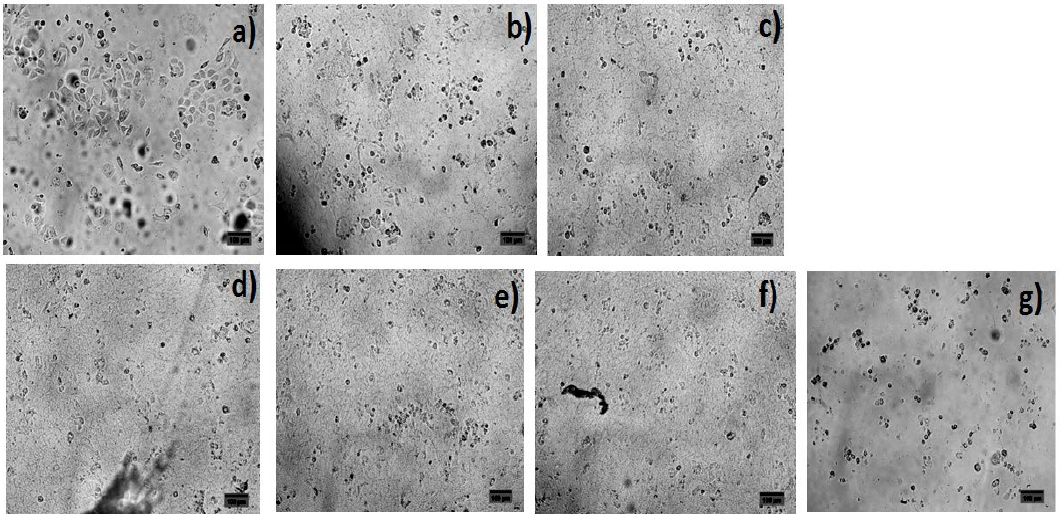
Fig. 10 Effect of the BL-AgNPs on the breast cancer MCF-7 cell line: (a) untreated cell line, (b) 20 μg/ml, (c) 40 μg/ml, (d) 60 μg/ml, (e) 80 μg/ml, (f) 100 μg/ml of BL -AgNPs (treated cell line) and (g) standard drug (Cis-platin)